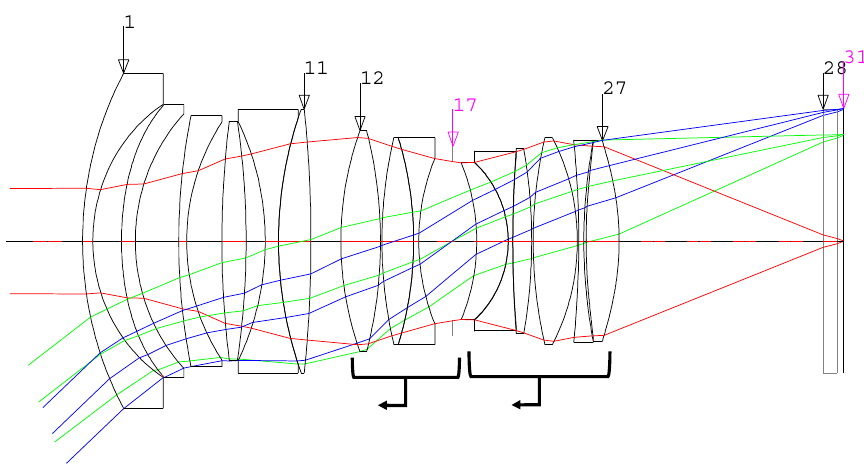
Figure 2. Optical layout for JP20160012034A2P, Example 1.